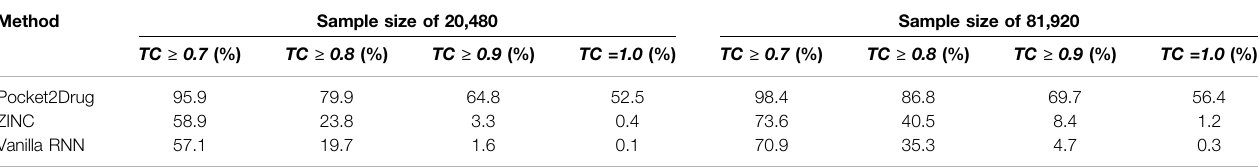
TABLE 1 | Hit rates for the Pocket2Drug-holo